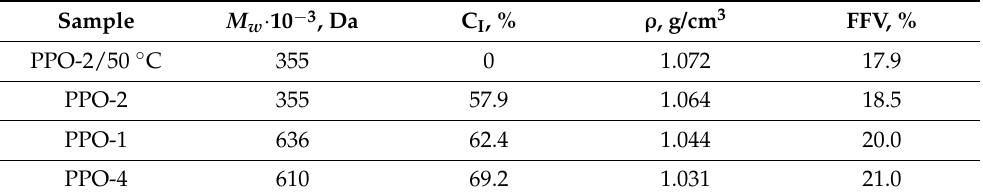
Table 2. The degree of crystallinity (C I ), density (p), and fractional free volume (FFV) of the studied PPO film samples.